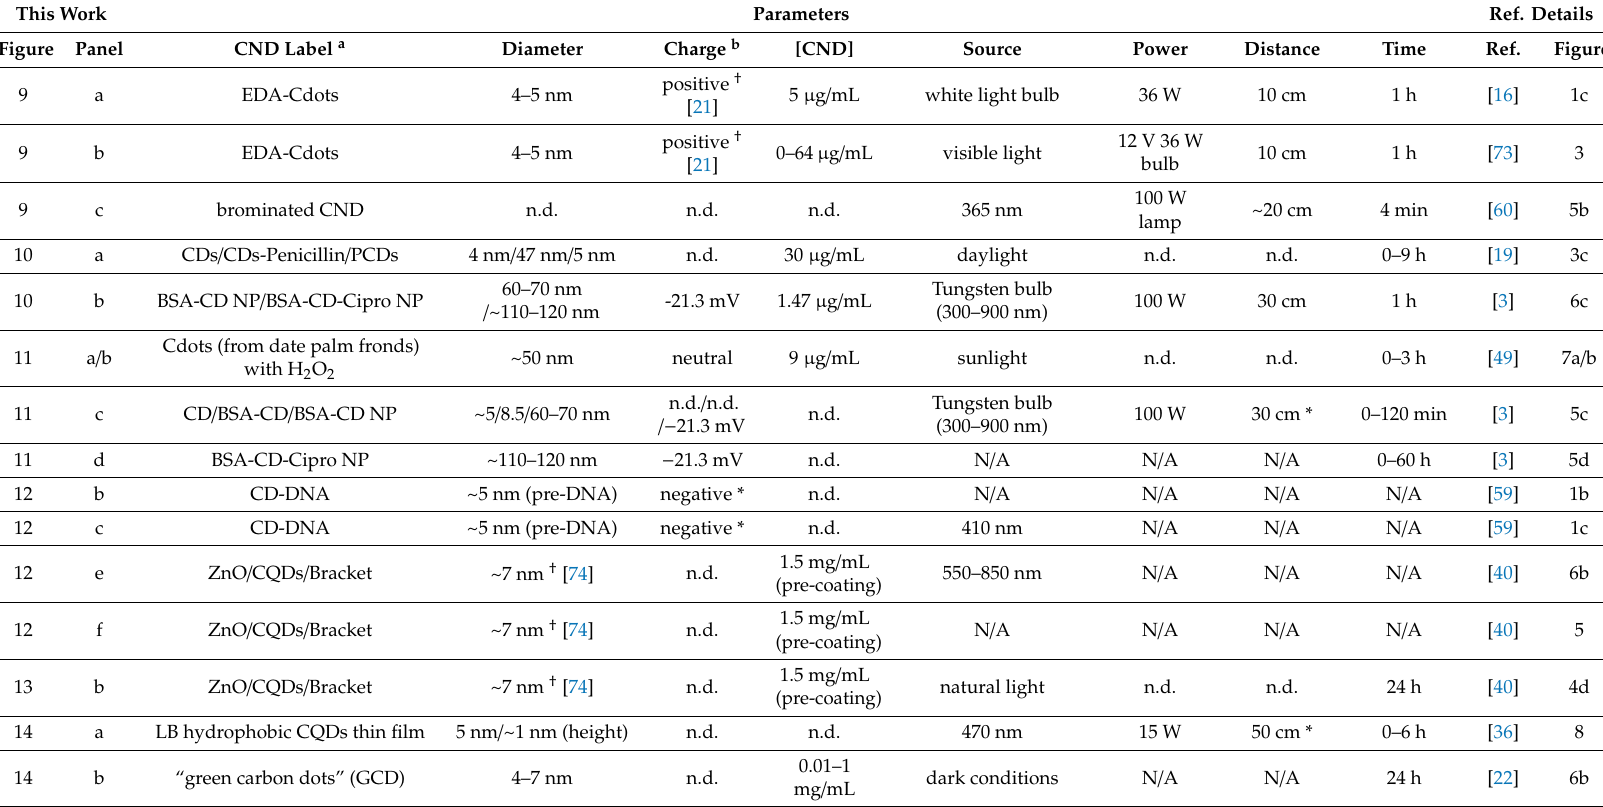
Table 2. Summary of Experimental Parameters for Studies Appearing in Figures for Sections 4 and